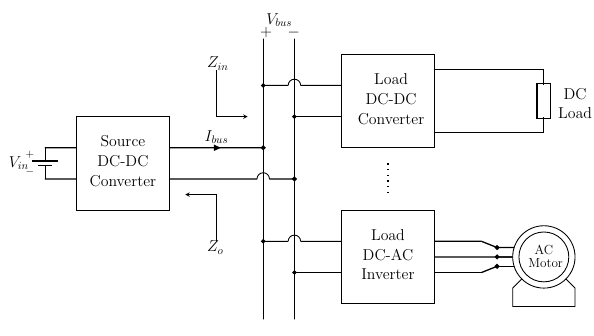
Figure 1. Cascaded DC-DC